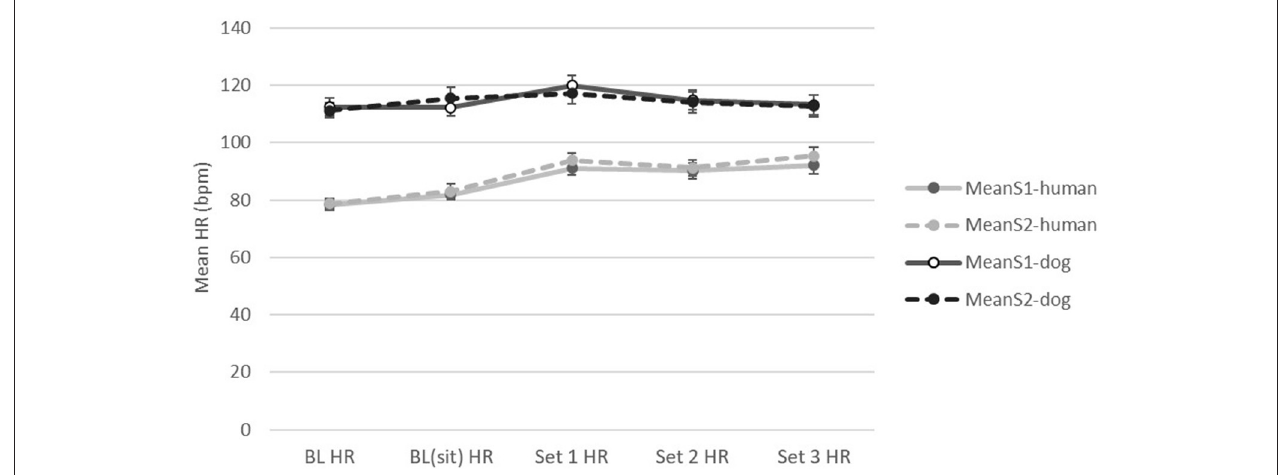
FIGURE 2 | Mean HR for canine and human participants for data collection sessions 1 and 2, during baseline and the three handling sets. As the majority of the handling exercises were conducted while the human and dog were seated, the baseline data when sitting [BL(sit)] were used for calculation of “difference from baseline” when available. When BL(sit) data were not available, baseline data for the entire baseline period (BL), including both sitting and standing, were used. No significant differences were found in the baseline “sitting” and overall mean baseline HR measurements, for either humans or dogs, in either session 1 or 2 (all p > 0.355).